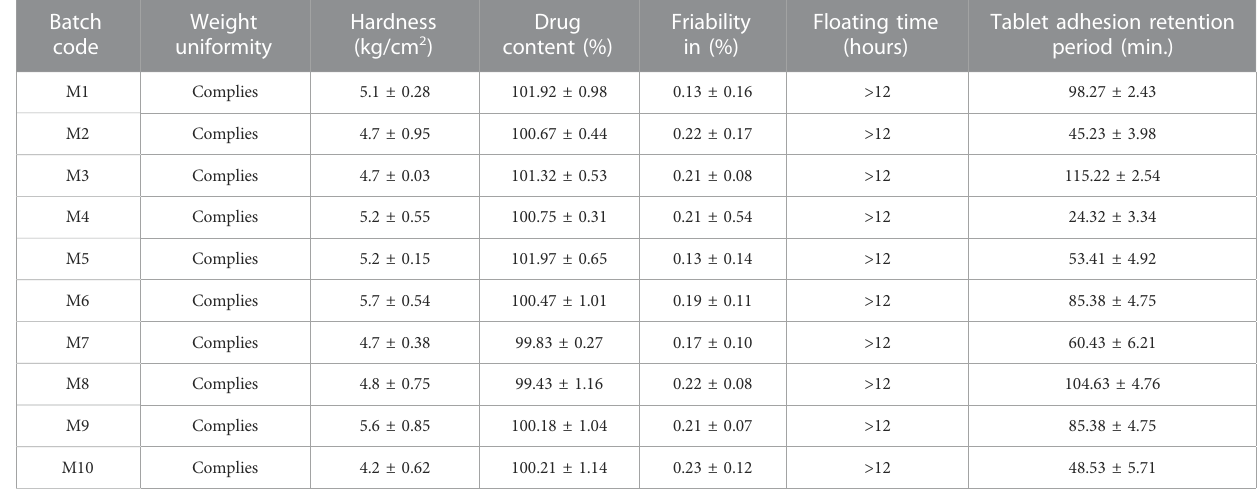
TABLE 2 Physical evaluation of the designed MTG fl oating matrix